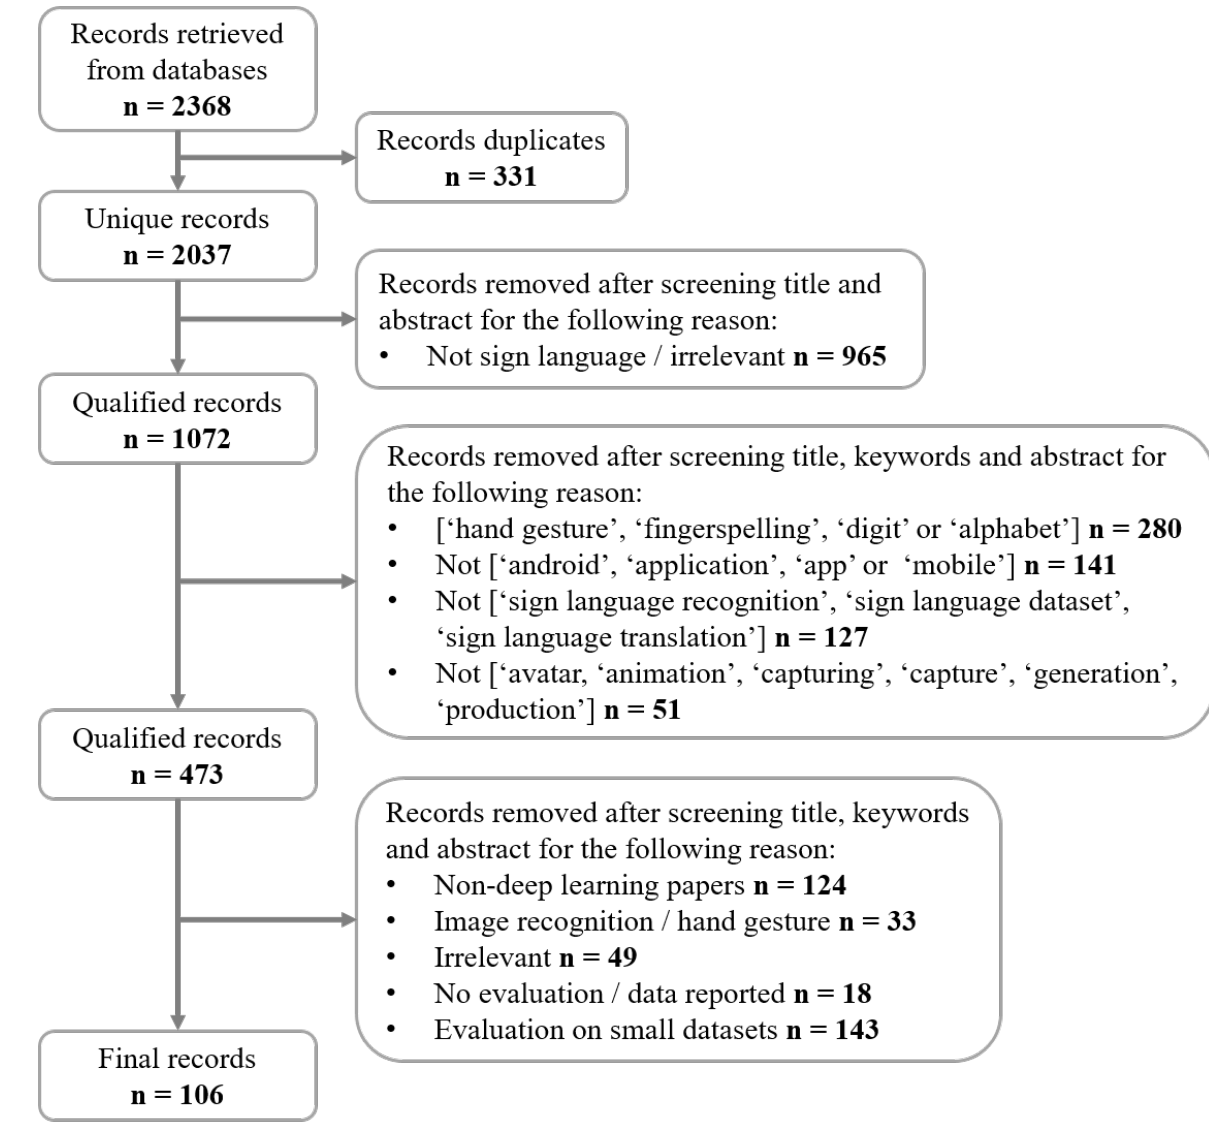
Figure 2. Flowchart of the systematic literature search